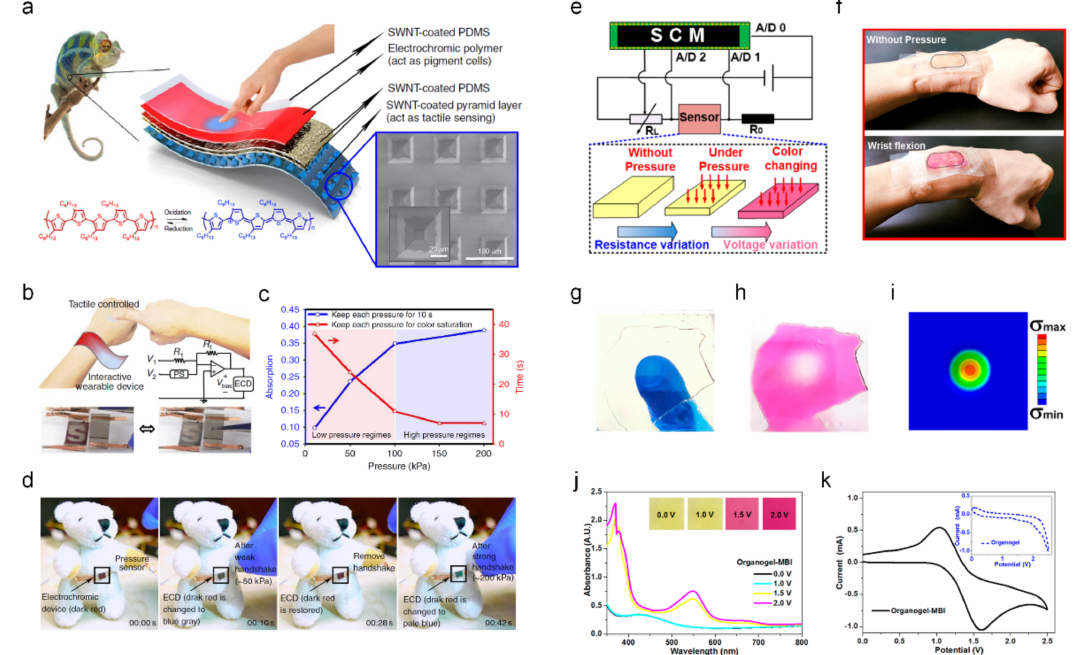
Figure 1. Wearable electrochromic devices (ECD) based on color-changeable e-skin integrated with a tactile sensor (( a – d ) adapted with permission from ref. [22], copyright 2015 Nature Publishing Group and ( e – k ) adapted with permission from ref. [23], copyright 2020 American Chemical Society). ( a ) Chameleon-inspired e-skin by electrochromic polymer in poly (3-hexylthiophene-2, 5-diyl) (P3HT) with single-wall carbon nanotubes-coated pyramid layer of the tactile sensor (inset SEM image). ( b ) Schematic layout of the interactive color-changeable e-skin with the circuit and photos of PSEC. ( c ) The adsorption and time versus the low-pressure and high-pressure regimes of the designed e-skin. ( d ) Interactive color-changing and tactile-sensing e-skin. Depending on the strength of the handshake (tactile sensing), the color of the ECD changes (visual detection). ( e ) The circuit diagram with the working mechanism of the EC-tactile sensor for direct visualization of the stresses. ( f ) Interactive color change of ionic polyacrylamide (PAAm) organogel depending on the wrist flexion. ( g ) Pressing the PAAm organogel by finger and ( h ) direct stress distribution caused by the finger press. ( i ) Finite element analysis simulation of the stress distribution. ( j ) UV-vis absorption spectra with an optical image (inset) of the ionic PAAm organogel under varied potentials. ( k ) Cyclic voltammetric diagram of the PAAm organogel with or without (inset) 1-methyl-4,4’-bipyridinium